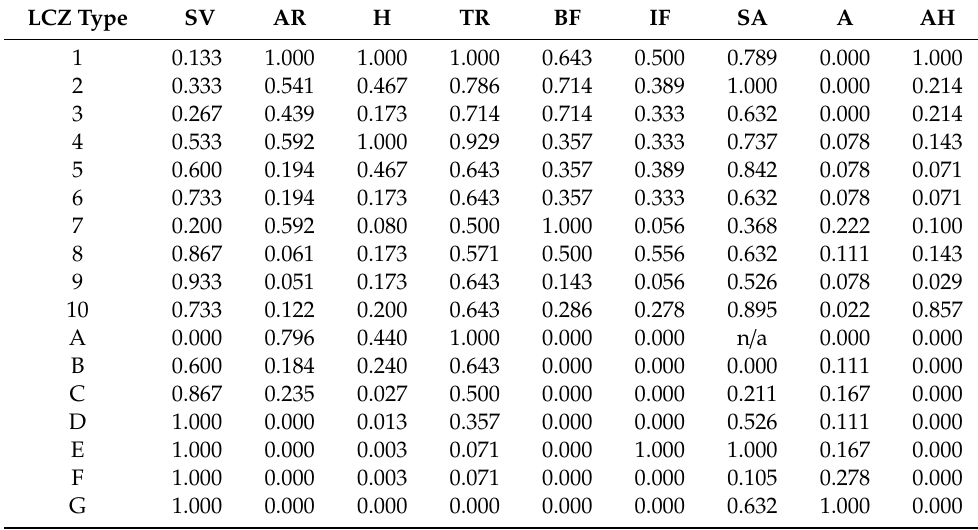
Table A1. P norm values for each LCZ type. Note: SV , AR , H , TR , BF , IF , SA , A , and AH columns show the P norm values of the parameters sky view factor, aspect ratio, mean building / tree height, terrain roughness, building surface fraction, impervious surface fraction, surface admittance, surface albedo, and anthropogenic heat flux,